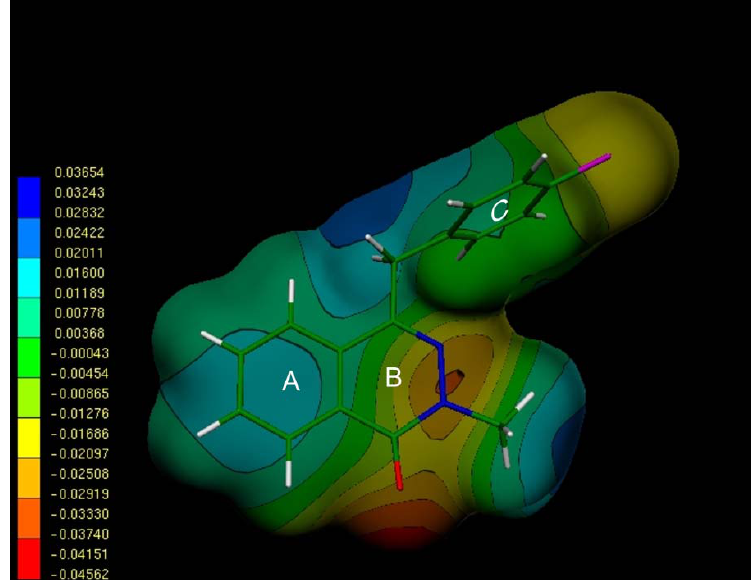
The surface was generated with GAUSSIAN 03 using a B3LYP/6-311++G(d,p) single point calculation. The colouring represents electrostatic potential with red indicating the strongest attraction to a positive point charge and blue indicating the strongest repulsion. The electrostatic potential is the energy of interaction of the positive point charge with the nuclei and electrons of a molecule. It provides a representative measure of overall molecular charge distribution. The colour-coding is shown on the